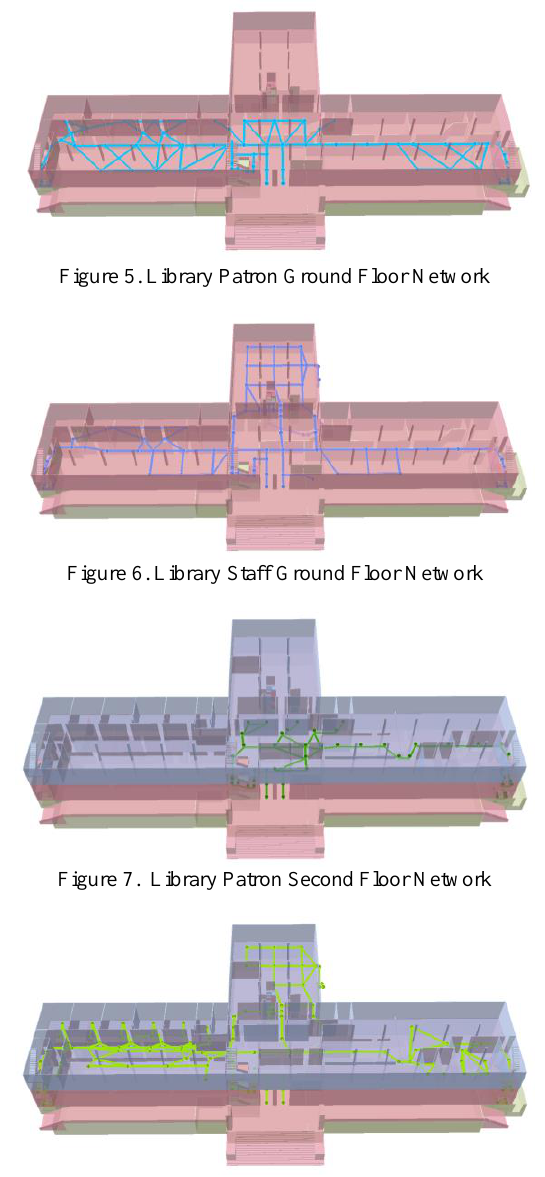
Figure 8. Library Staff Second Floor Network